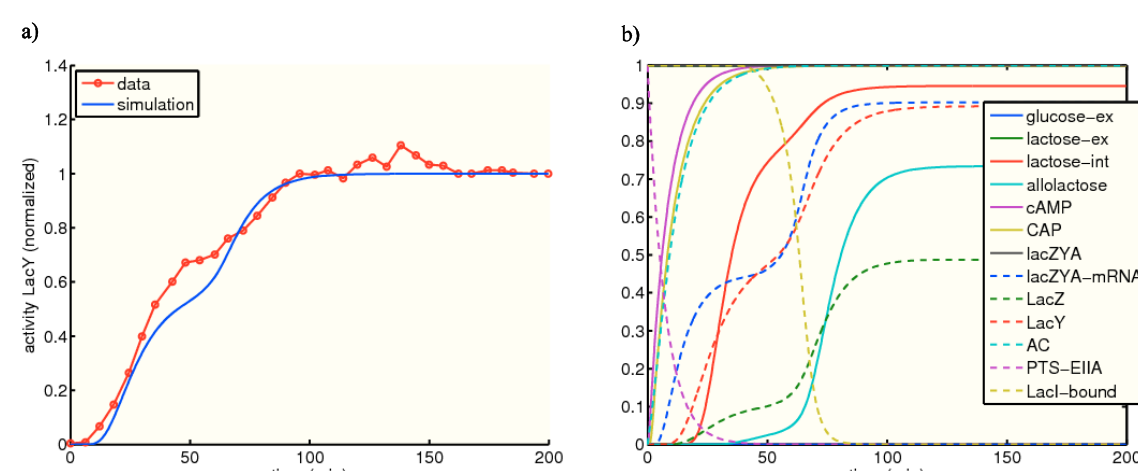
Figure 4: ODEfy simulations of the lac operon when switching from growth on glucose to lactose. a) LacY data (taken from [40]) and resulting ODEfy-interpolation after parameter estimation. b) Resulting dynamics of all state variables.